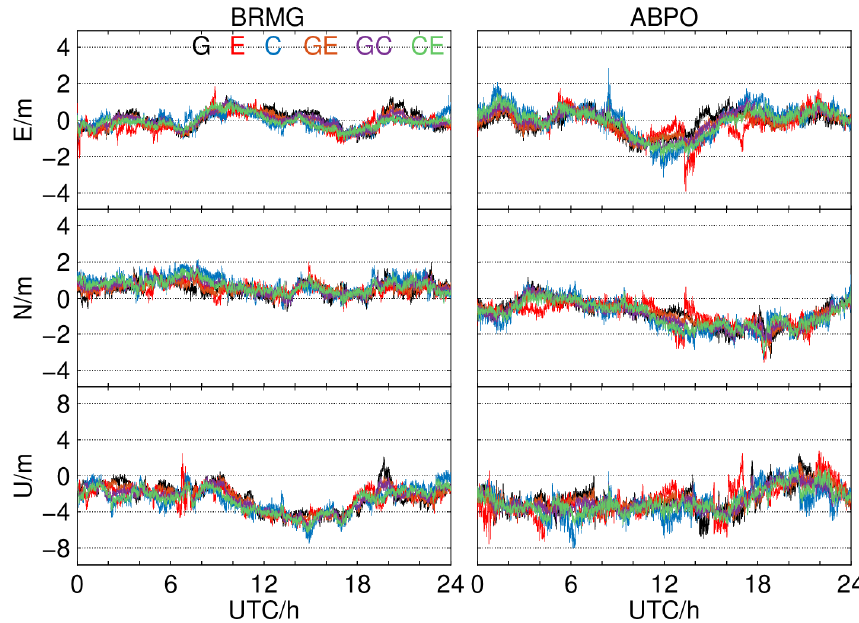
Figure 13. Dual system positioning errors for the E, N, and U components of the two tracking stations of BRMG and ABPO.